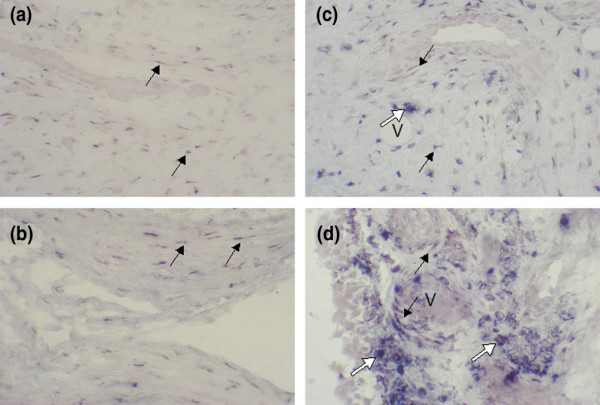
Fibroblasts (black arrows) expressing bone morphogenetic protein (BMP)-4 (a) and BMP-5 (b) in areas with fibrosis in osteoarthritis synovial tissue (original magnification ×20). Macrophagocytic (white arrows) and fibroblastoid (black arrows) appearance of cells adjacent to vessels (V) expressing BMP-4 (c) and BMP-5 (d) in rheumatoid arthritis synovial tissues (original magnification ×40).